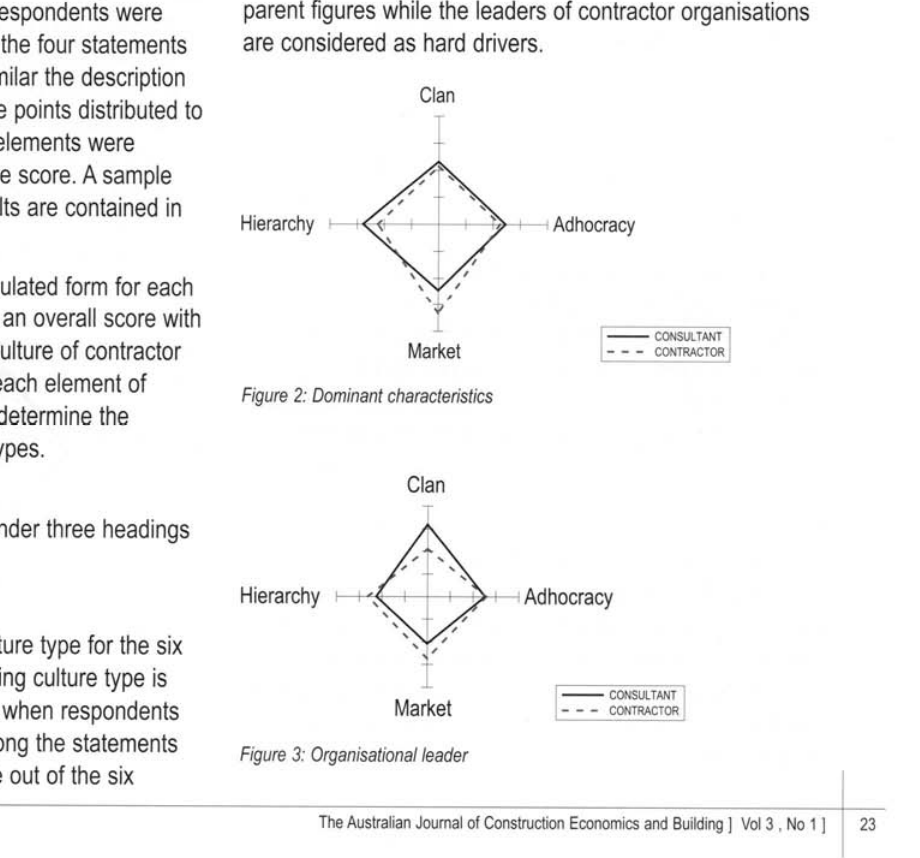
Figure 2: Dominant characteristics